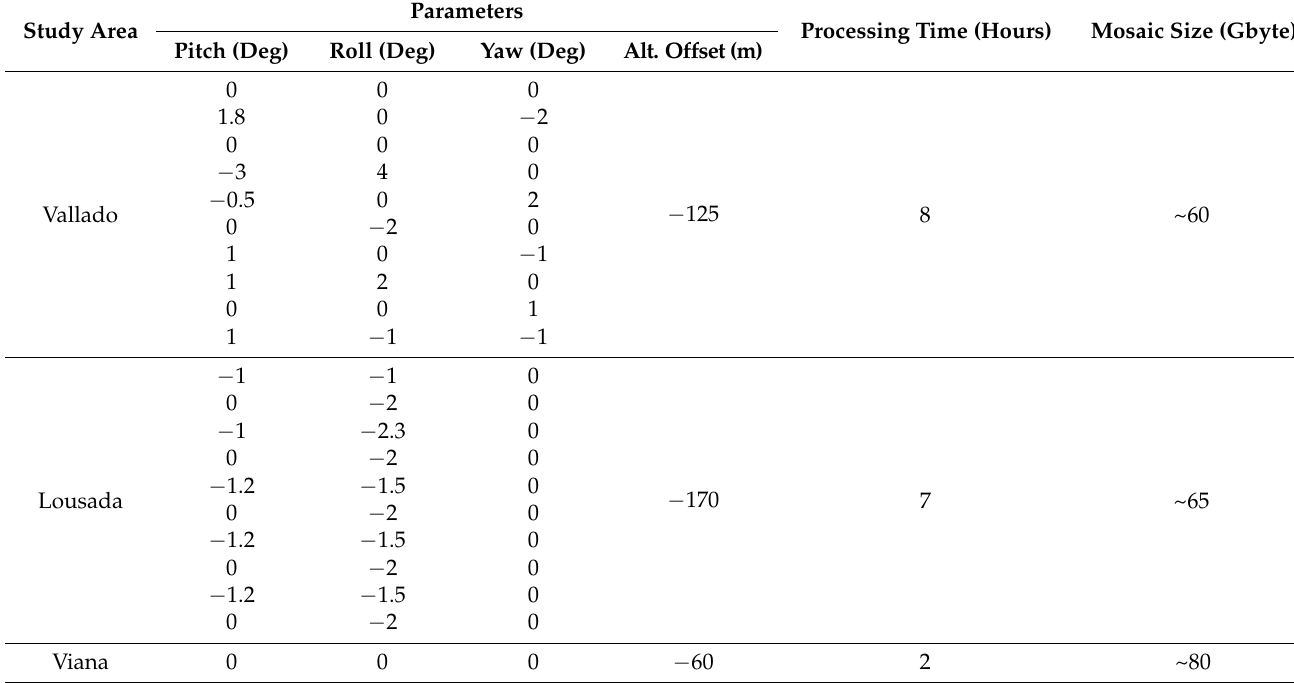
Table 6. Parameters used and total processing time of the final hyperspectral ortho mosaics. A single value in a cell means the same value has always been used. The altitude offset is set up subtracting the geoid undulation to the average altitude of the area.